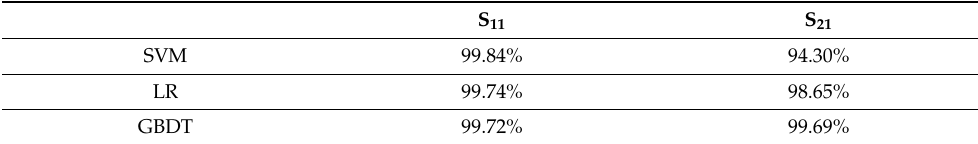
Figure 15. ROC curves for different algorithms trained on ( a ) S 11 , ( b ) S 21 . Table 7. AUC for three algorithms.